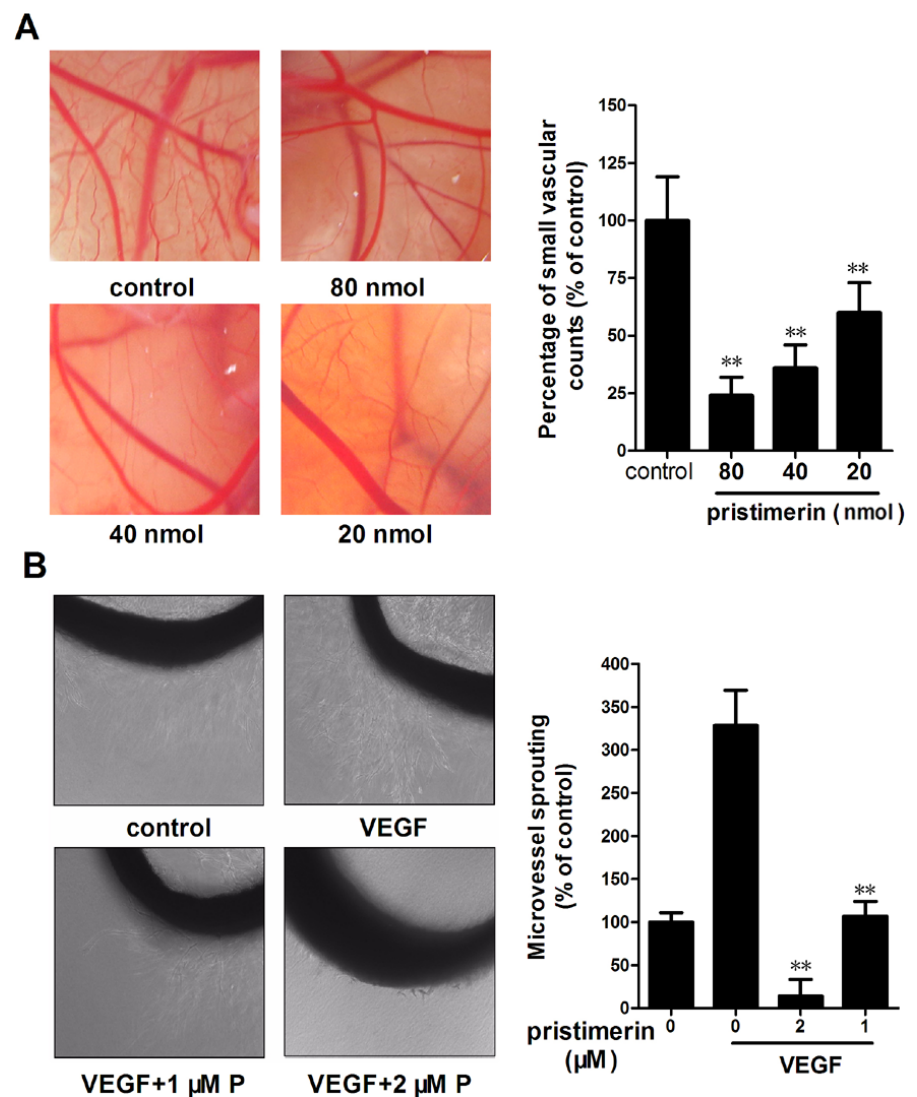
Figure 3. Pristimerin inhibits angiogenesis in vivo and VEGF-induced vessel sprouting ex vivo. ( A ) Effect of pristimerin on new blood vessel formation in CAMs. CAM were treated with pristimerin for 48 h, and then harvested and photographed. Quantification of neovascularization of the CAMs. Columns, mean; bars, SD. * p < 0.05 or ** p < 0.01 versus control; ( B ) Effect of pristimerin on microvessel sprouting in mouse aortic ring assay. Aortic segments isolated from Sprague-Dawley rats treated with VEGF (20 ng/mL) in the presence or absence of pristimerin for 7 d (magnification, ×100). P, pristimerin; Columns, mean; bars, SD. ** p < 0.01 versus VEGF